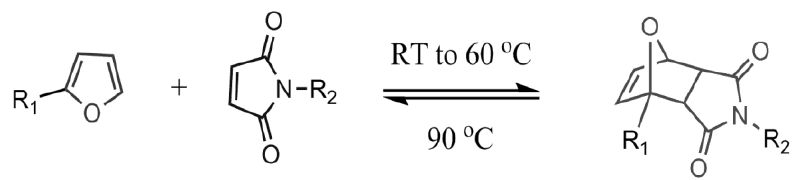
Figure 1. Diels-Alder reaction between furan and